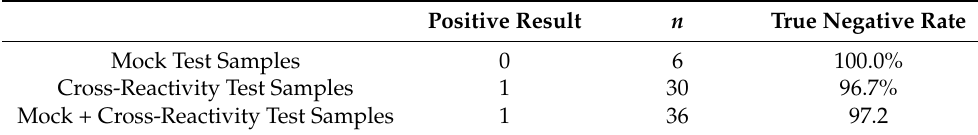
Figure 9. Assay sensitivity on blinded XPRIZE samples: The set of blinded XPRIZE samples com- prised 123 samples with an unknown concentration SARS-CoV-2 Twist synthetic RNAs in water or SARS-CoV-2 ZeptoMetrix particles in phosphate-buffered saline (PBS), nasal sample, or saliva sample. True positive rate ( y -axis) is shown for different concentrations ( x -axis) across the different matrices. The number of samples tested at each concentration for a sample type is represented by the values above the x -axes. Table 2. True negative rates based on results from testing blinded XPRIZE